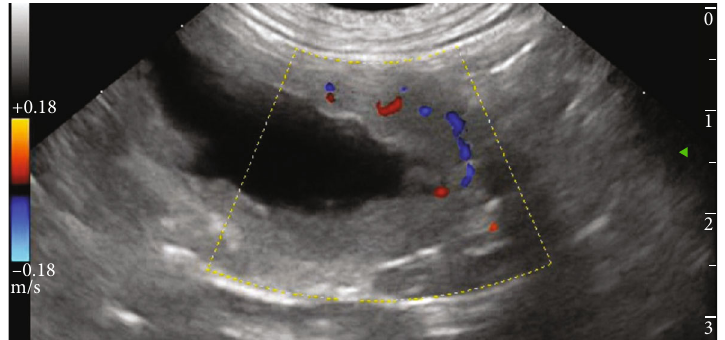
Figure 2: Abdominal ultrasound, left lateral approach. Cranial end of the fl uid- fi lled tubular structure identi fi ed as the left hydronephrotic/atrophic kidney. Some tracts of renal vascularization are still